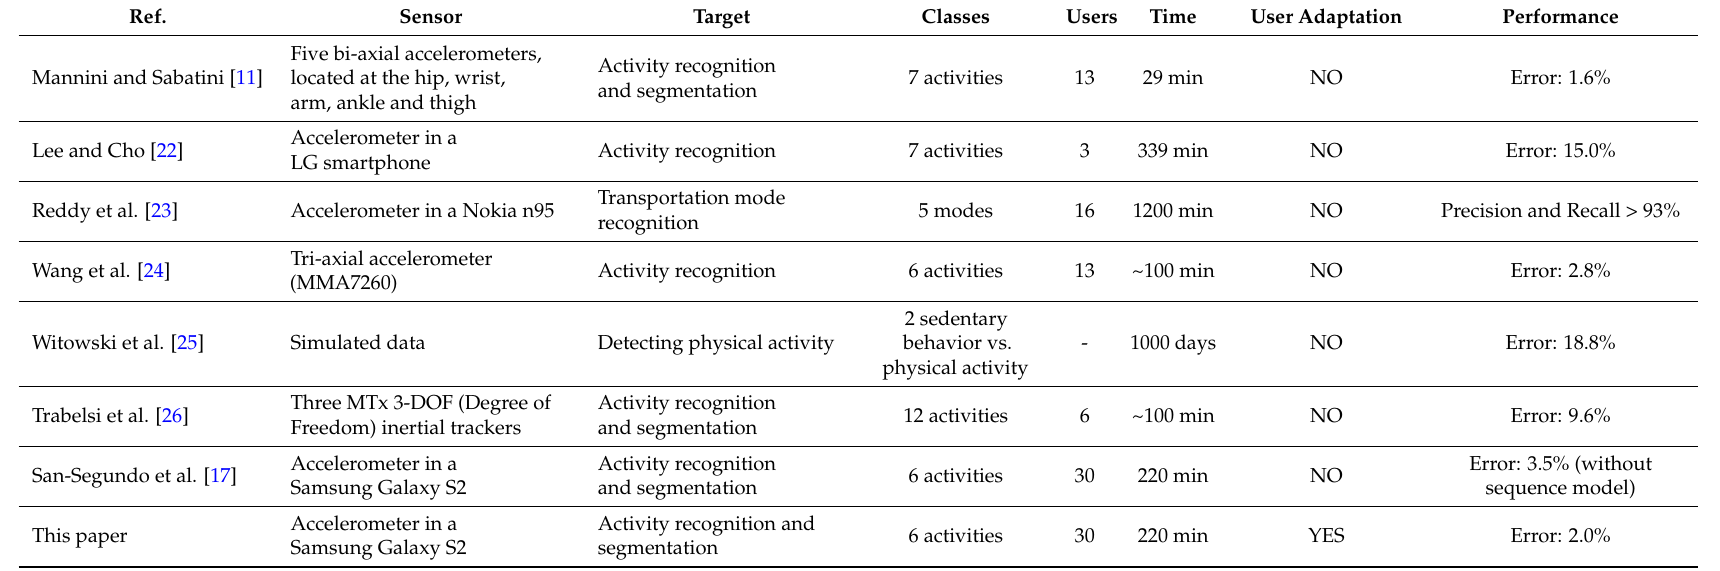
Table 1. Comparison of previous HAR works based on